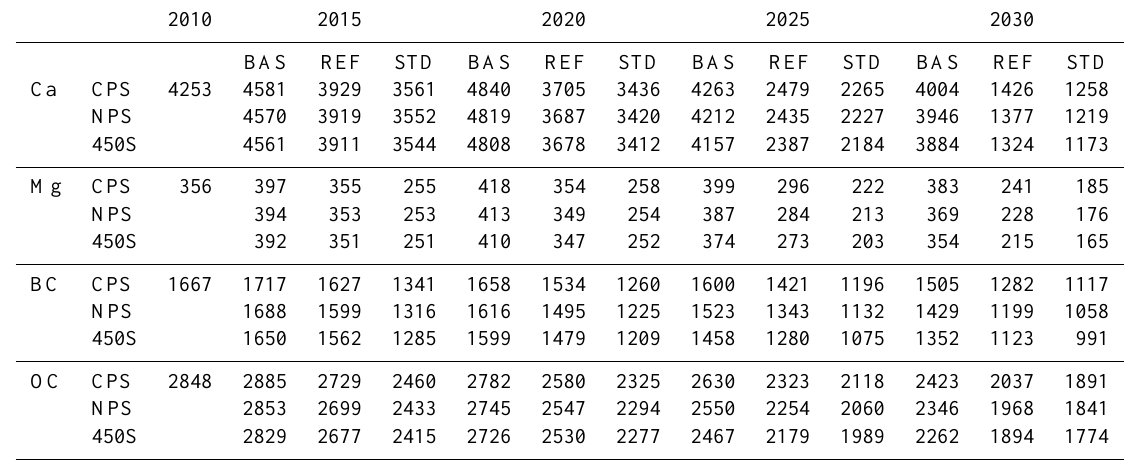
Table 4. Projected national emissions of chemical species of PM (Ca, Mg, BC, and OC) for 2015, 2020, 2025 and 2030 by scenario (unit: Gg). The emissions of 2010 (Y. Zhao et al., 2013) are listed as well for comparison